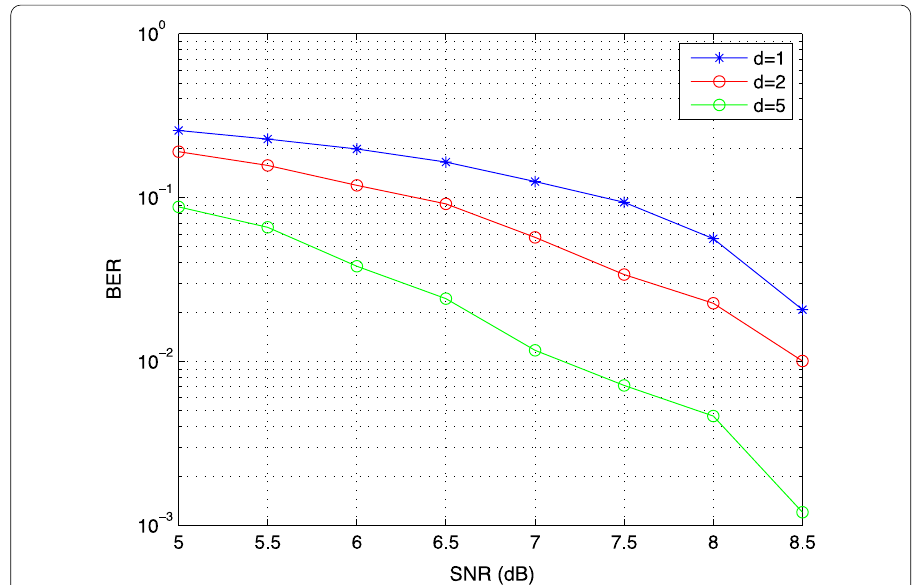
Fig. 3 BER performance comparison against SNR (dB) for d